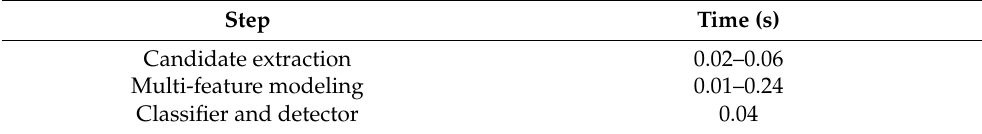
Table 6. Time consumption of each step of the process.